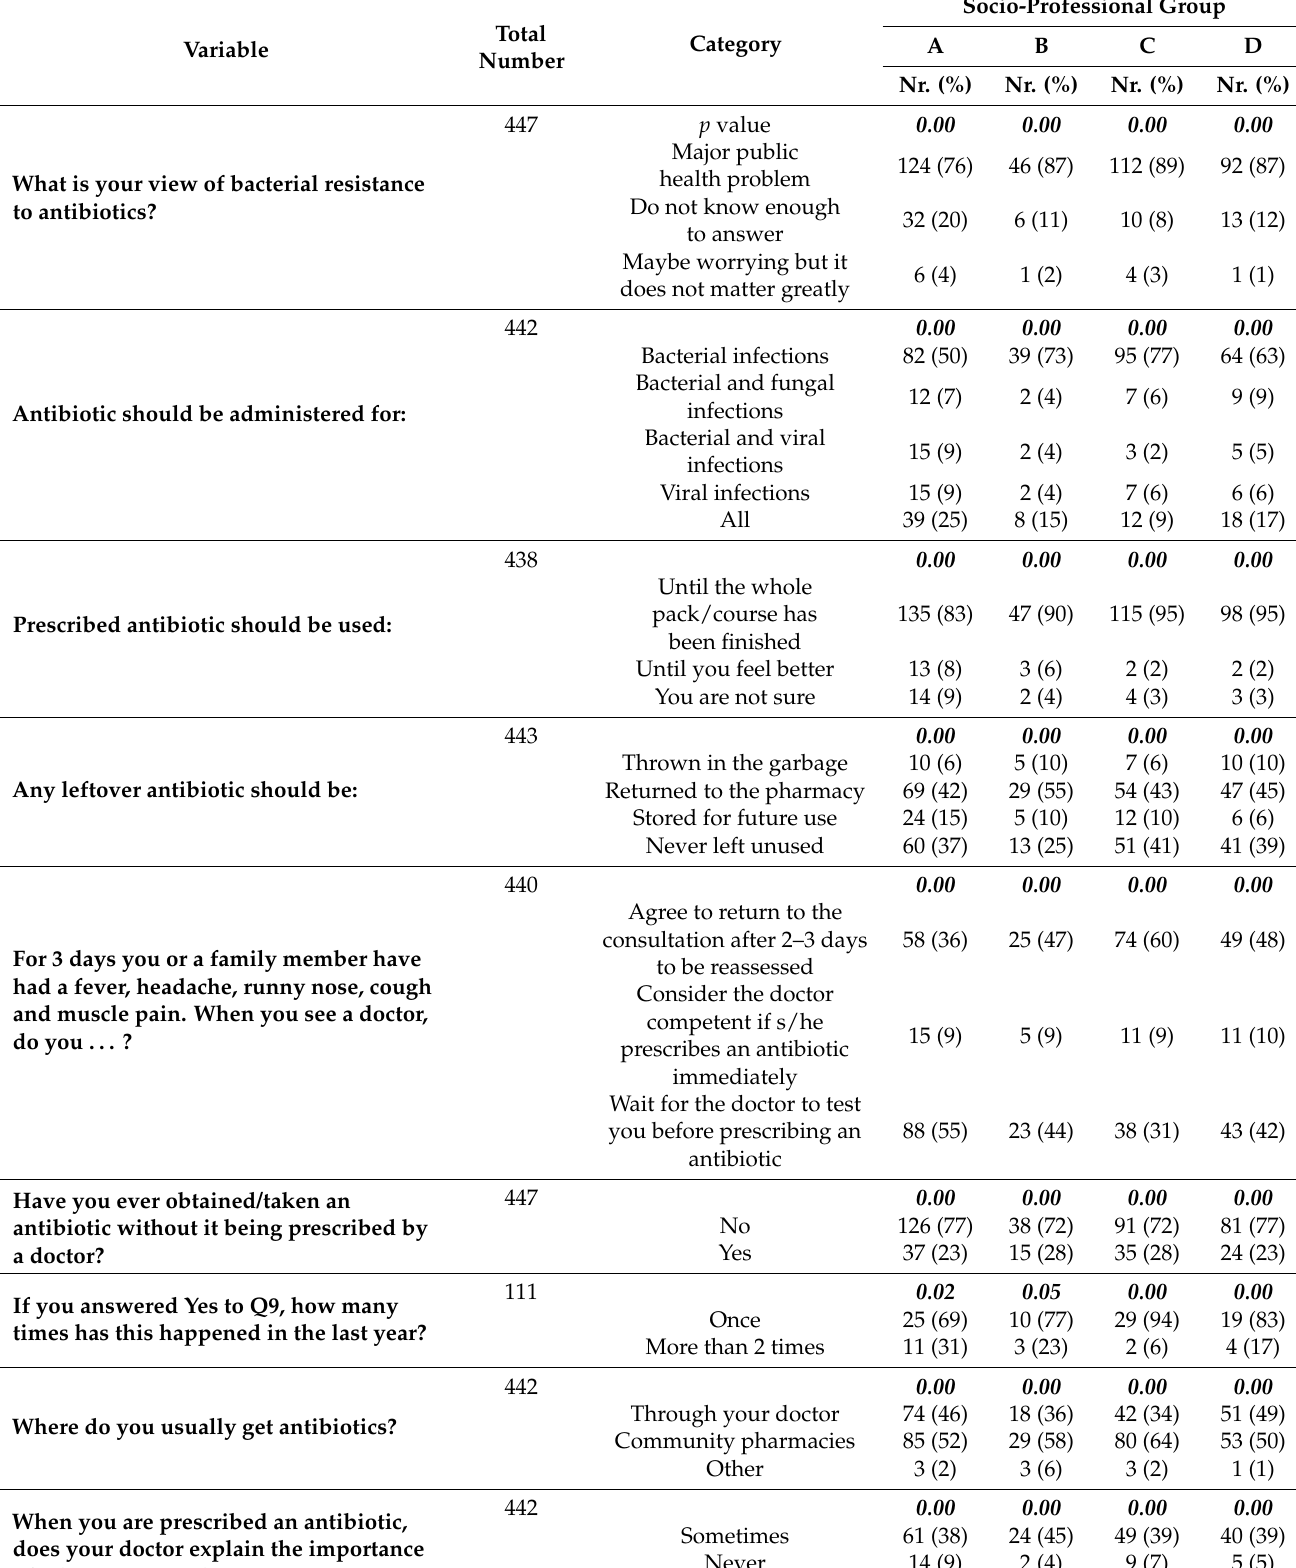
Table 4. Proportions of general knowledge and personal use of antibiotics by the socio-professional group